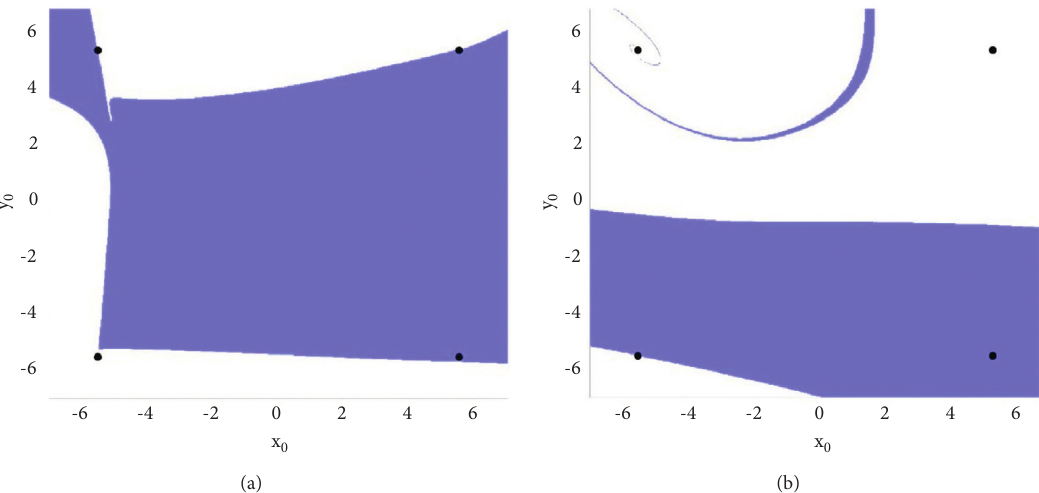
Figure 4: The system’s basin of attractions ( a � 0 . 5 and b � 2 . 3). According to our best search, the system has just one attractor. Different initial values of the systems are attracted to the attractor or have unbounded responses. White color is considered for plotting in both (a) and (b) parts for the initial values with unbounded responses. Regions that are attracted to the attractor are plotted with blue color. (a) and (b) are �� √ �� √ responsible for plates that Z � 23 and Z � − 23 , respectively. Because some equilibrium points can be found in blue regions, the system can be categorized in the self-excited class.